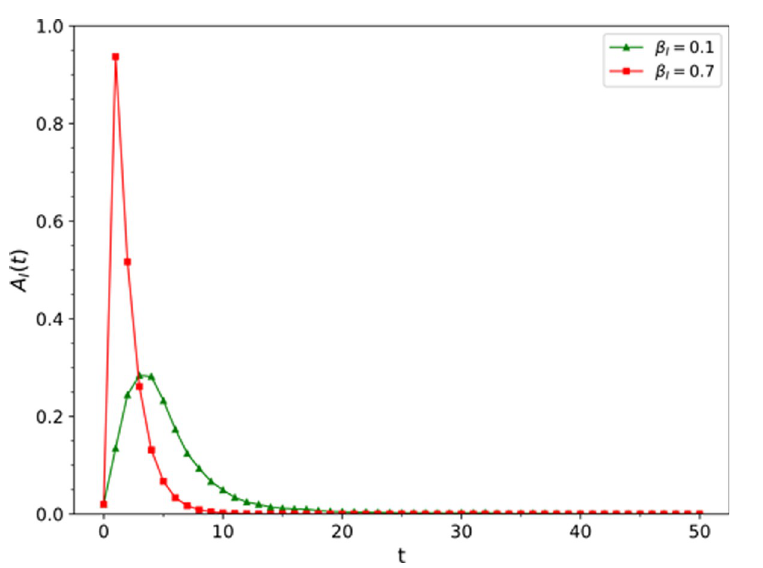
Fig 2. The influence of the information disseminatioin rate β